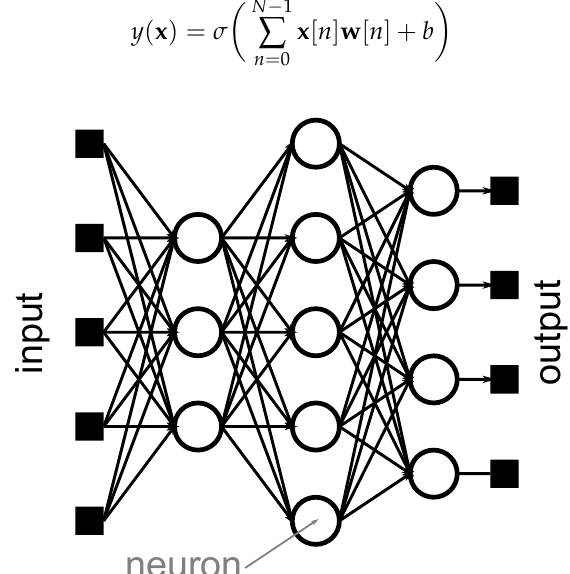
Figure 2. An abstract example of a neural